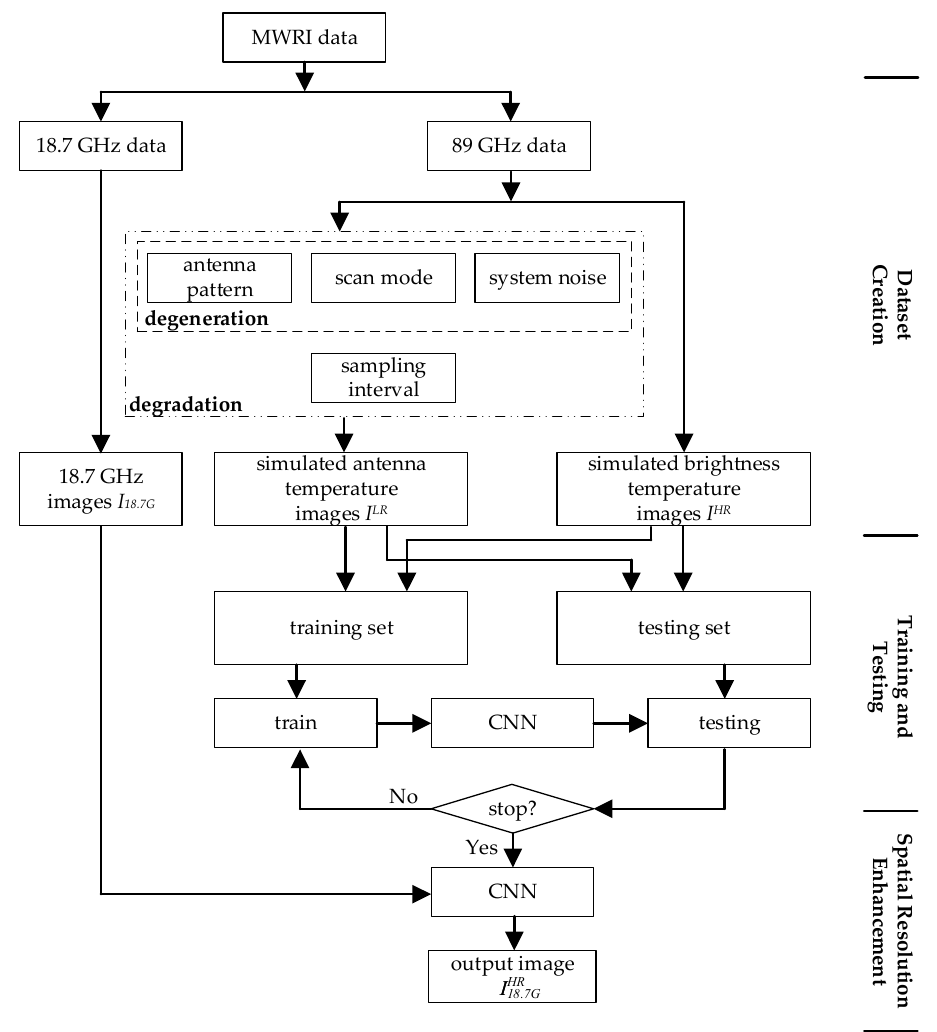
Figure 6. The flowchart of the resolution enhancement task.